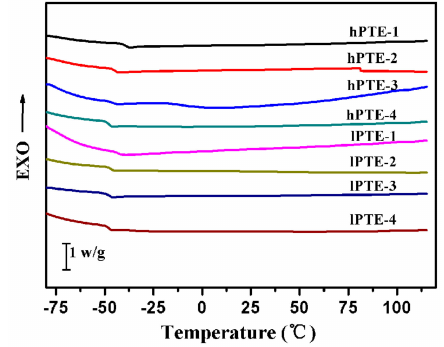
Figure 5. DSC curves of hPTE and lPTE copolymers at a heating rate of 10 ◦ C min − 1